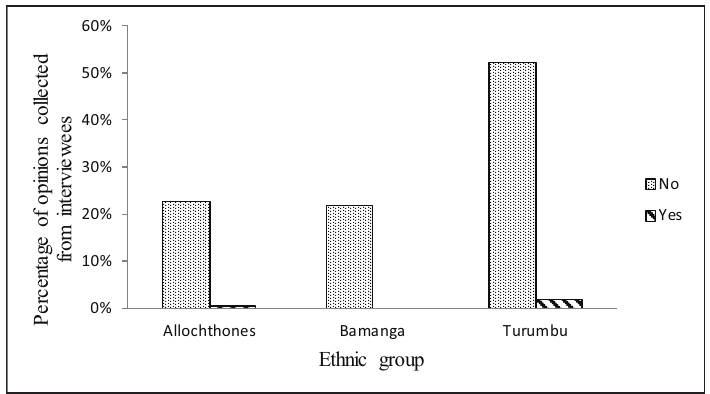
Figure 2. Extent to which local communities were consulted in the creation of YBR and in project design.